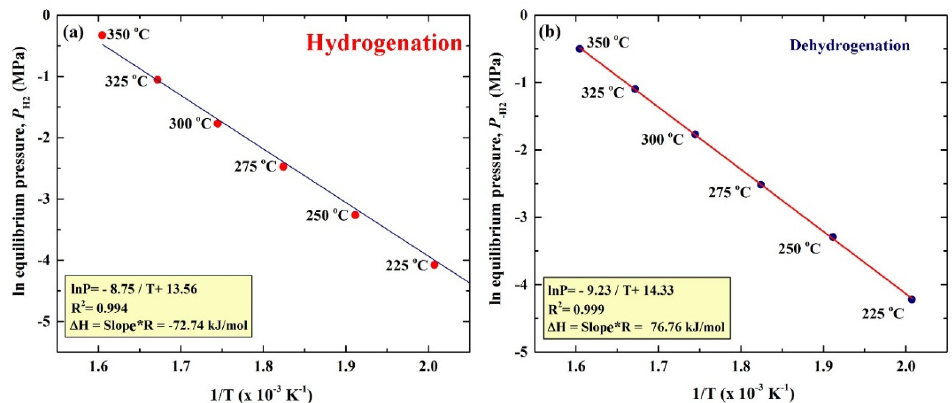
Figure 7. van’t Hoff plot of the plateaus shown in Figure 6 for the ( a ) hydrogenation, and ( b ) dehydrogenation of ball-milled MgH 2 /5.2TiC/4.6FeCr nanocomposite powders obtained after 50 h.